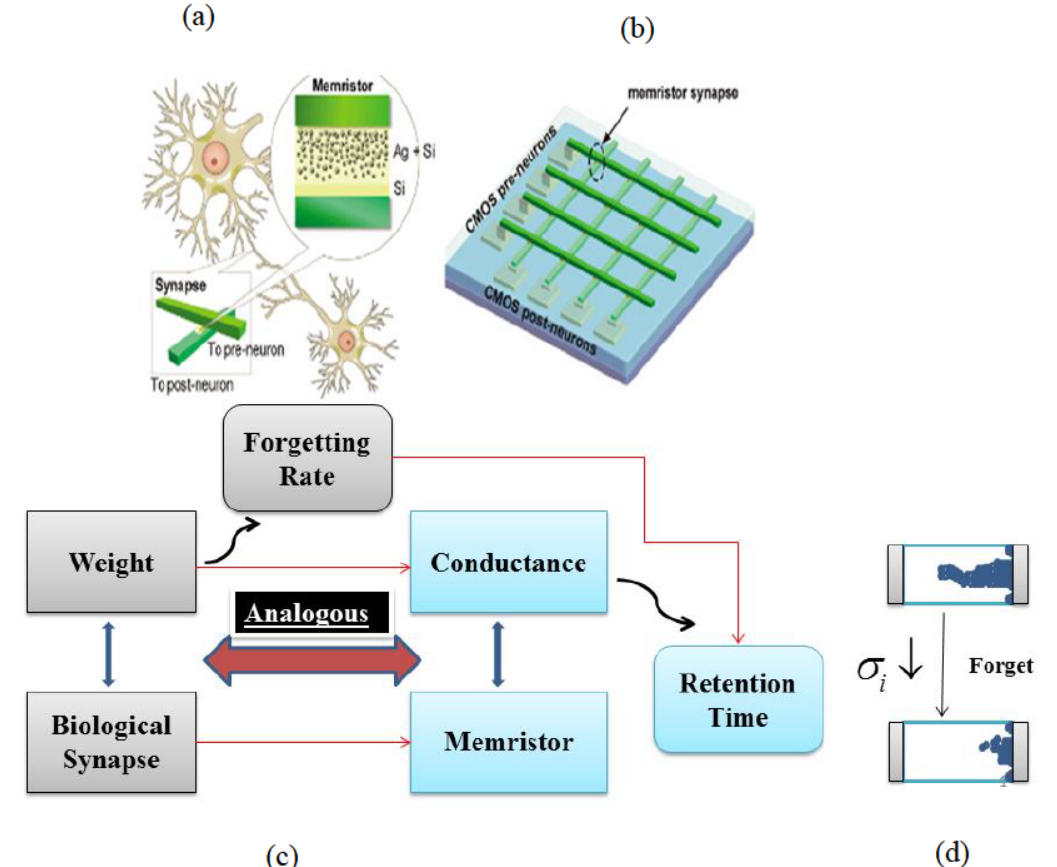
Figure 13: (a) Schematic presentation of the concept of employing memristors as synapses between neurons. The inset exhibits the layered stack structure of the memristor and schematics of the two-terminal memristor device. (b) Schematic representation of CMOS neurons and memristor synapses in a crossbar configuration. (c) Analogous between Biological and Artificial synapse. (d) Drop in the level of ionic conductivity ( σ i ) related to forgetting rate, analogous to memory decay. (Reprinted with permission from H. J. Sung, T. Chang, I . Ebong,